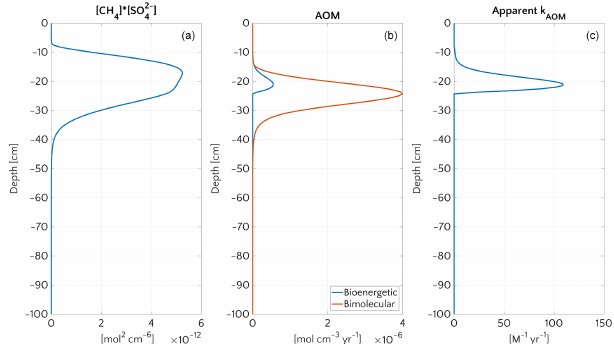
Figure 9. Vertical profiles at the end of transient simulation (af- ter 200 years) with bioenergetic AOM formulation for the case [ CH ] − = 1 . 169mM and v up = 5cmyr − 1 . (a) Bimolecular prod- 4 ] . (b) AOM rate according to the bioenergetic for- uct [ CH 4 ]·[ SO 2 − 4 mulation (blue) and, for comparison, according to bimolecular for- mulation used for the steady-state simulations (red). (c) Apparent k AOM , estimated from Eq. (5).